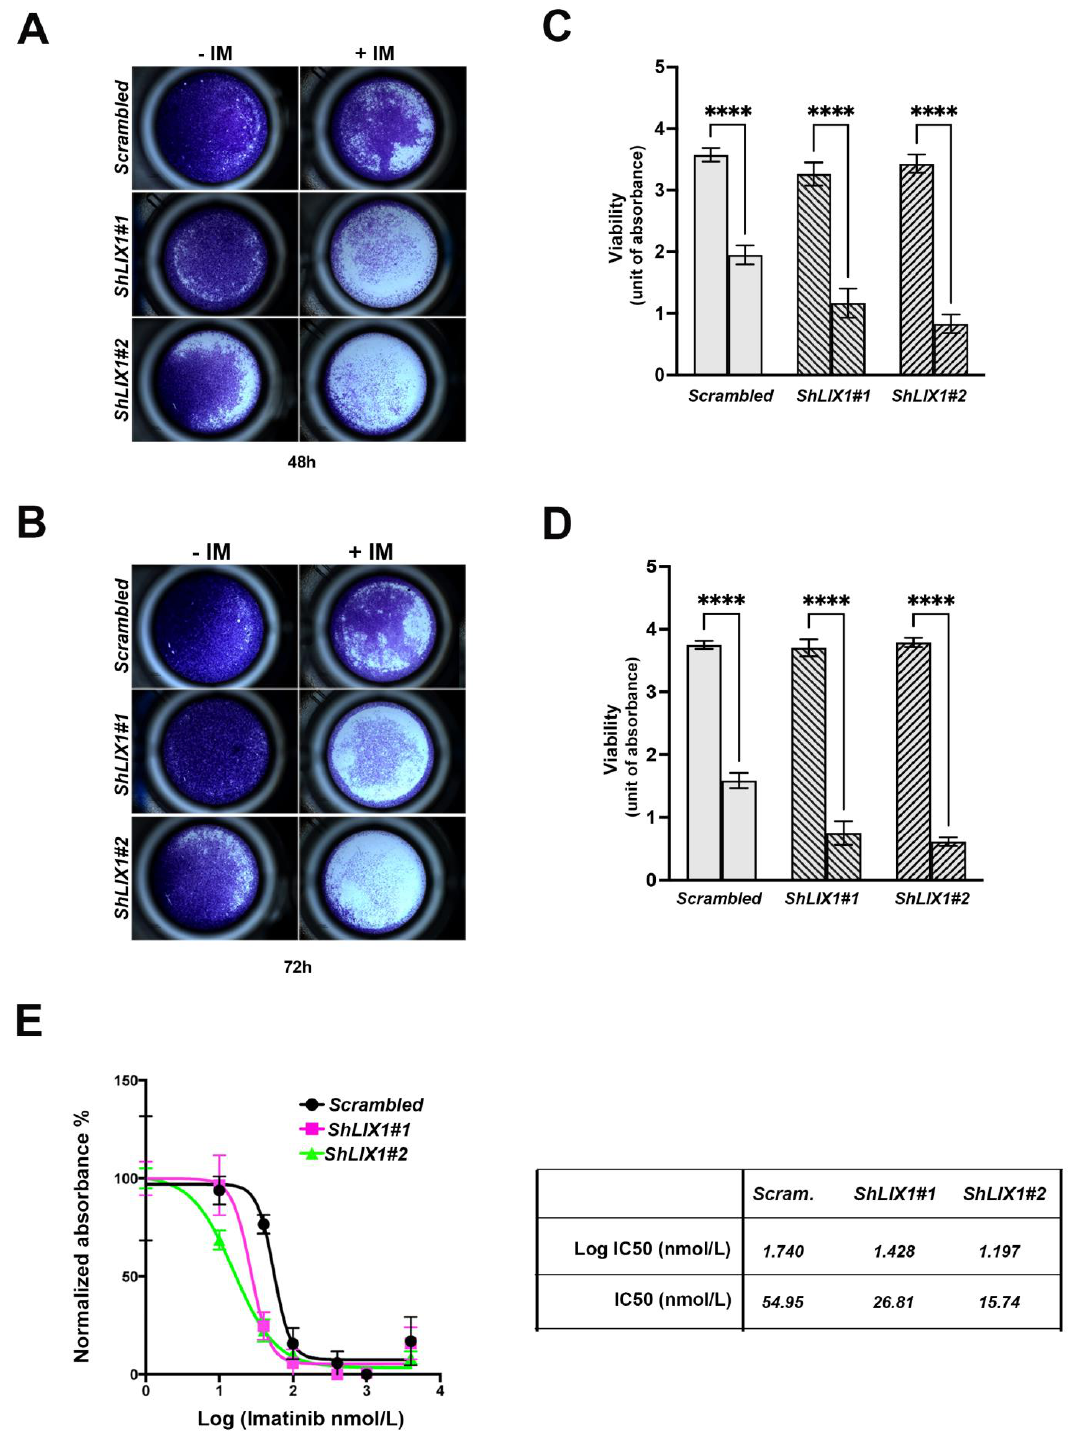
Figure 4. LIX1 silencing enhances imatinib anti-tumor in GIST cells. ( A , B ) Crystal violet staining of GIST-T1- Scramble, GIST-T1- ShLIX1#1, and GIST-T1- ShLIX1#2 cells incubated (+IM) or not (-IM) with 0.5 µ M imatinib. All plates were fixed, stained, and imaged after 48 h ( A ) or 72 h of treatment ( B ). ( C , D ) Quantification of cell viability in the different GIST-T1 cell lines at 48 h ( C ) and 72 h ( D ) of treatment. Values are the mean ± SEM of eight independent experiments; **** p < 0.0001 (one-way ANOVA). ( F ) Imatinib IC 50 shows the potentiation of the imatinib effect upon LIX1 silencing in GIST-T1